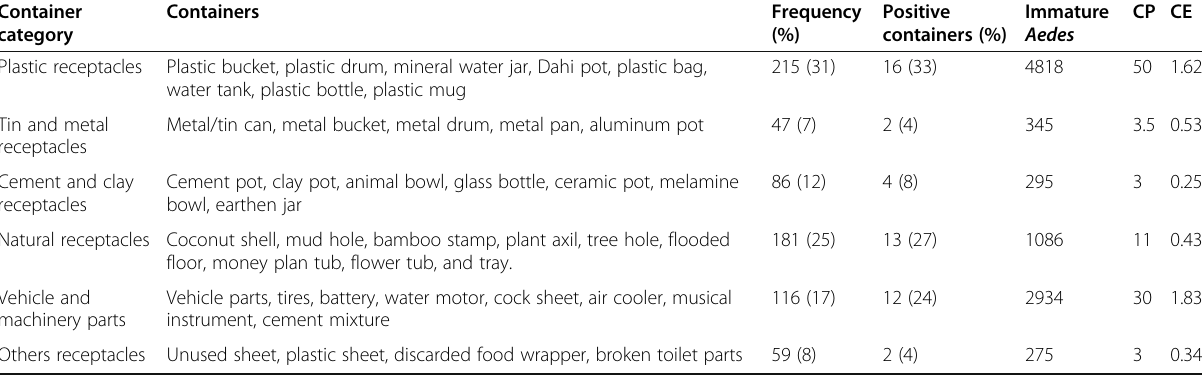
Table 3 The efficiency of different container categories for the production of Aedes larvae Container category